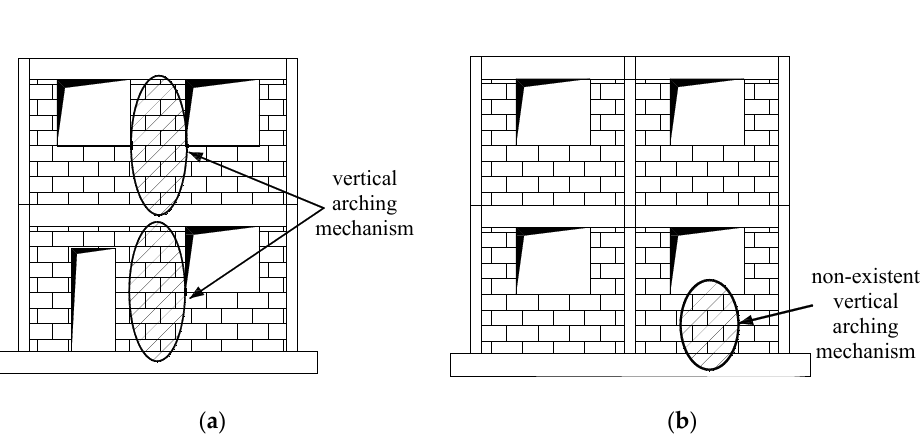
Figure 15. Influence of the distribution of the openings in the formation of a vertical arch effect in the tested models: ( a ) possible vertical arch mechanism in the longitudinal infill walls; ( b ) absence of a vertical arch mechanism in the transversal infill walls (horizontal arching mechanism possible).